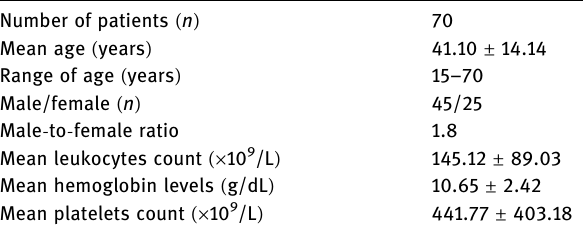
Table 1: Clinical and laboratory details of CML patients in study Number of patients ( n )